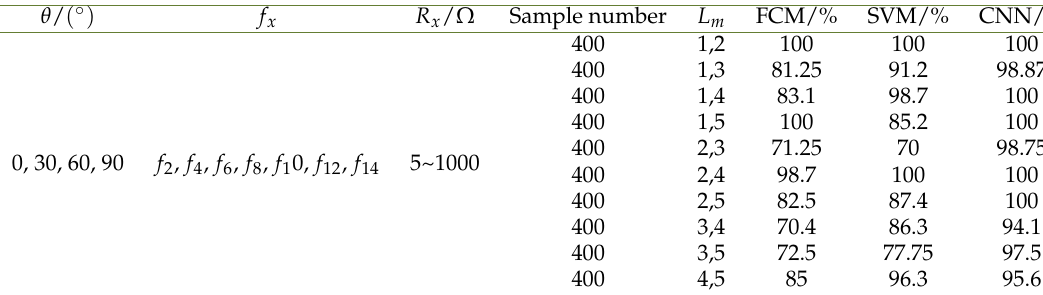
Table 7. Testing results of line selection of two-point grounding